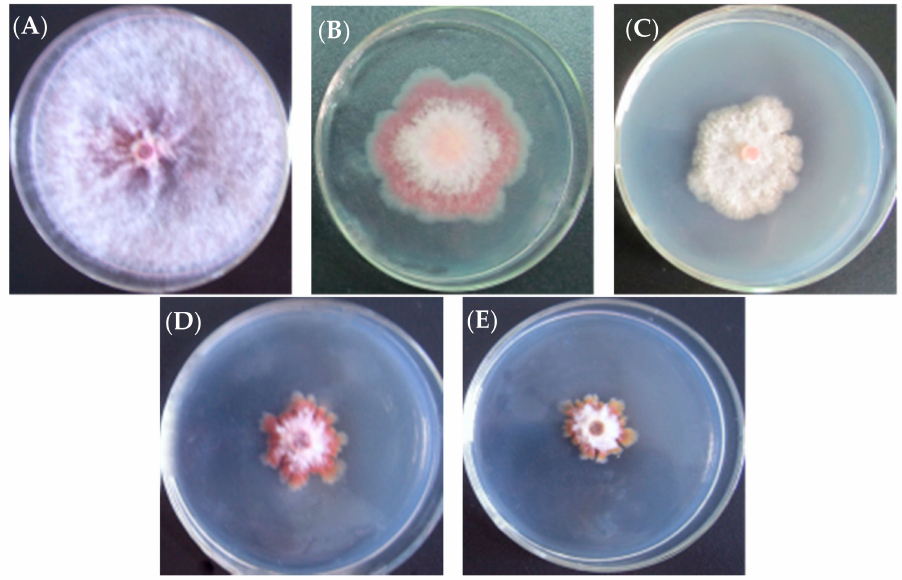
Figure 3. Inhibitory effects of L -cyclopropylalanine on F. graminearum Schw on PDA plates at different